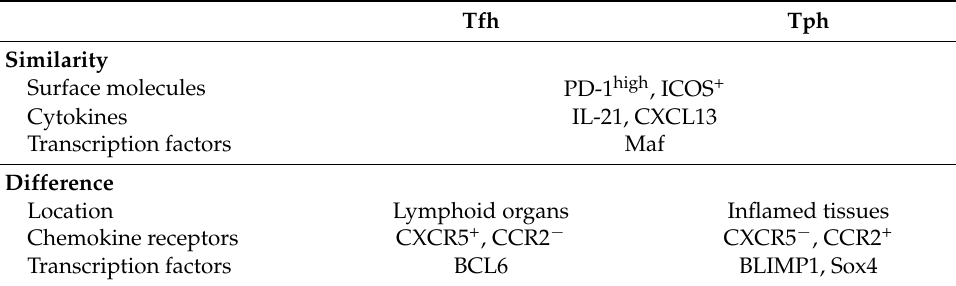
Table 1. Similarities and differences between Tfh and Tph cells.